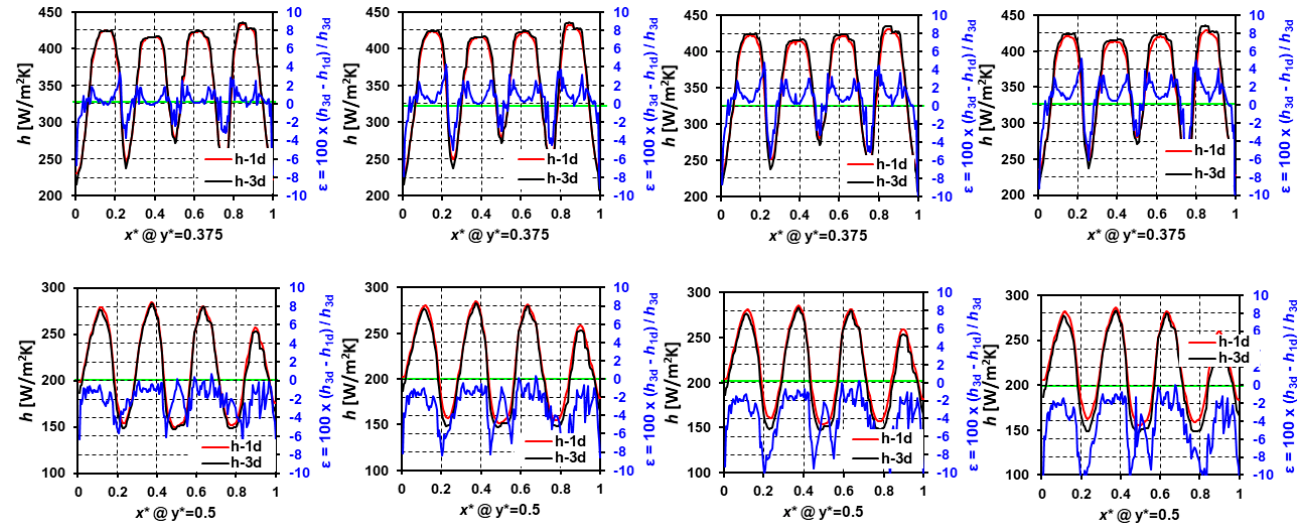
Figure 17. Method D, Case III: Local h variation at y* = 0.375 and y* = 0.5 and their relative % differences.